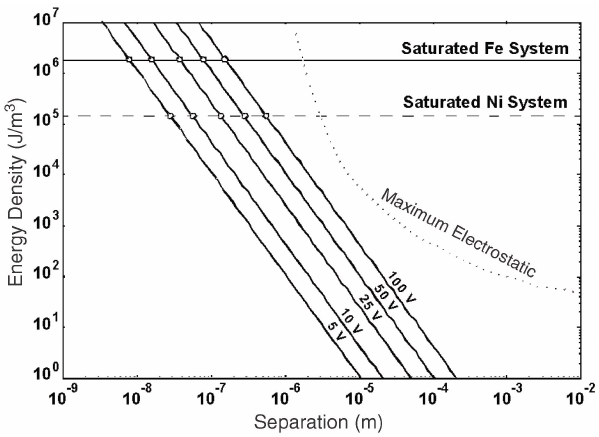
Figure 4. Comparison of electrostatic and magnetic energy densities as a function of characteristic gap dimensions for various voltages [95]. The dotted line is derived from the Paschen curve [96]. Reprinted with permission from [95]. Copyright 2001 IOP